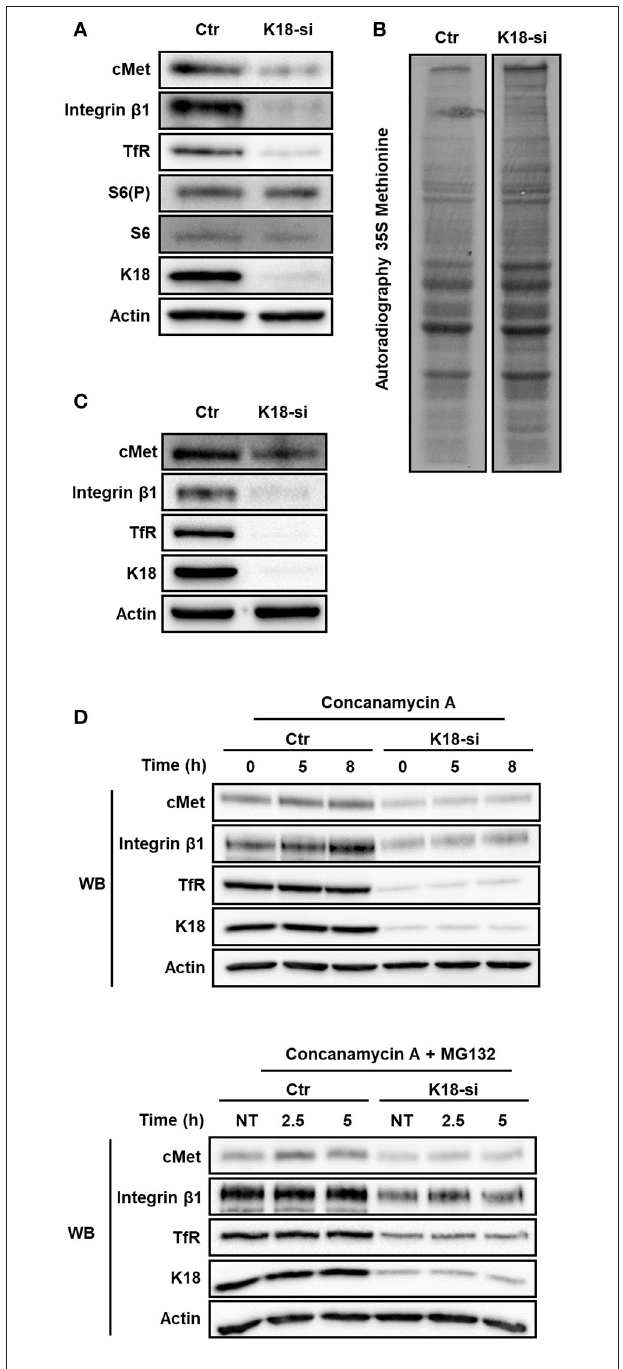
FIGURE 7 | K18 depletion does not dampen mTOR/S6K signaling, global protein translation and receptor degradation. (A) Activation of mTOR/S6K signaling pathway in K18 (K18-si) depleted HeLa cells was assessed by immunoblotting whole cell extracts against phosphorylated S6 (S6(P)), total S6, cMet, K18, and Actin as loading control. Immunoblot representative of three different experiments. (B) Rate of total protein synthesis was assessed by 35 S-methionine incorporation of HeLa cells transfected with control (Ctr) or K18 targeting (K18-si) siRNA. Autoradiography representative of two independent experiments. (C) Depletion efficiency of the samples that were